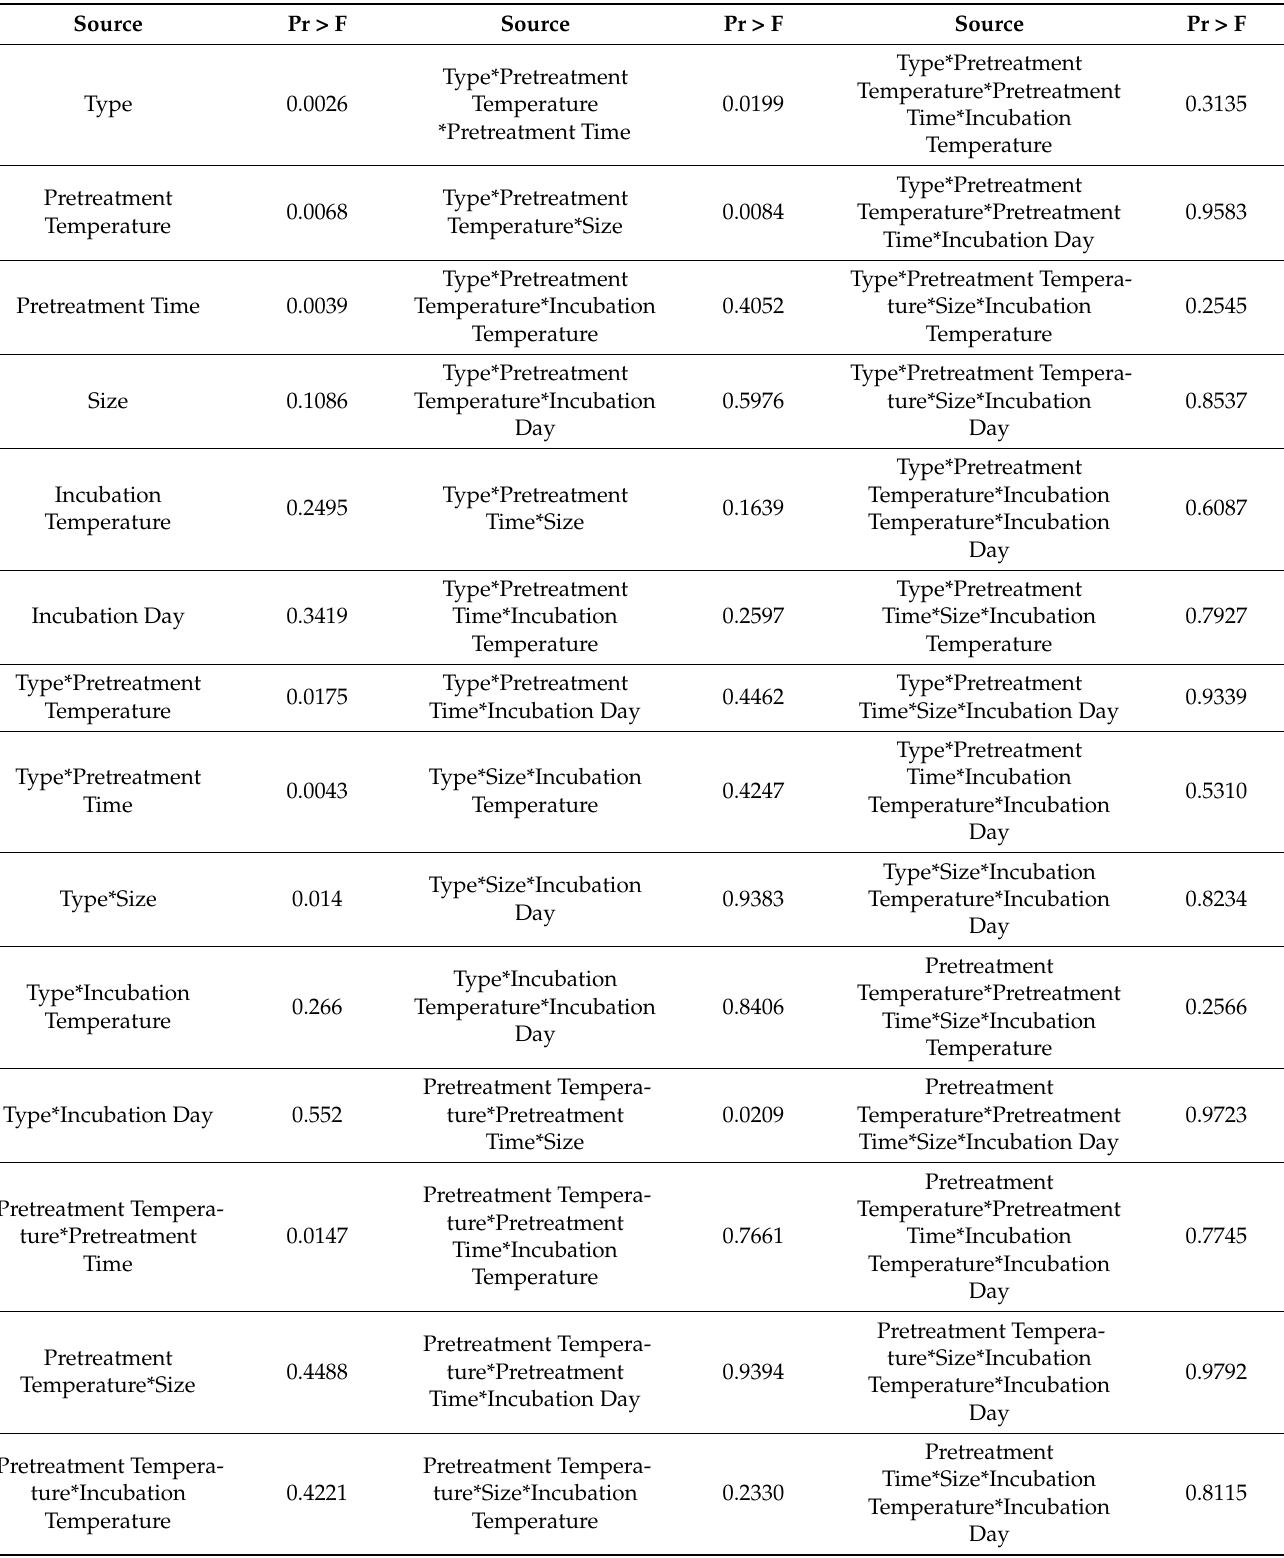
Table 10. p -value summary for CEL yield